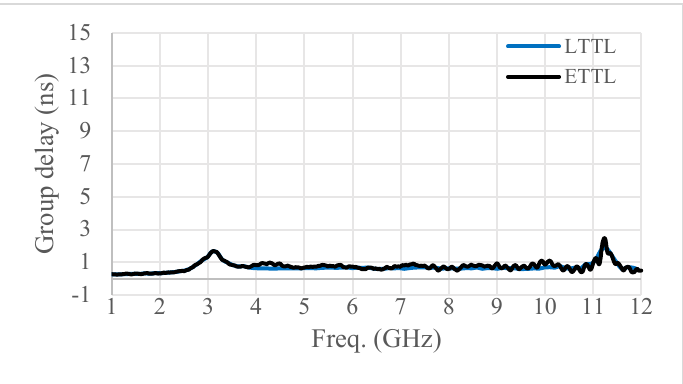
Figure 11. Simulated and measured S-parameters of the proposed filters (represented in Figure 6). ( a ) ETTL of k / β 0 = 0.50. ( b ) Equivalent LTTL.